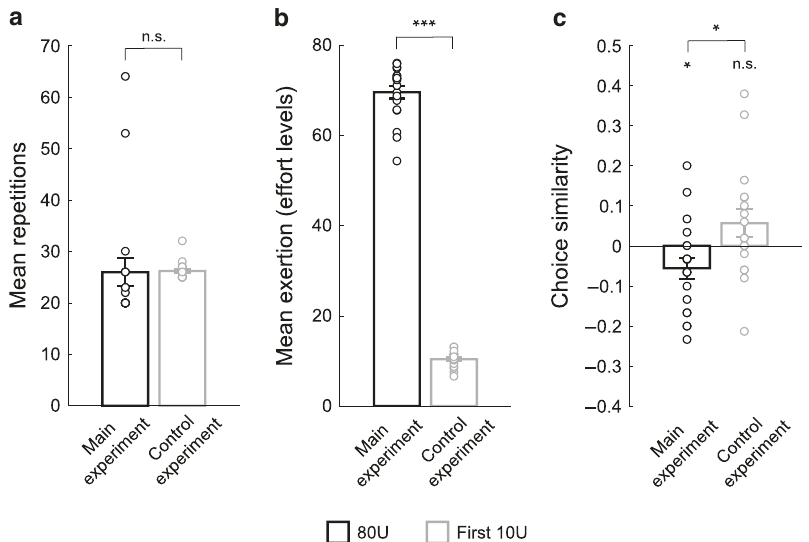
Fig. 7 Comparison of choice preferences during high and low exertion efforts, controlling for the number of exertion repetitions (participants from the Main Experiment and Control Experiment 2; n = 37). a We compared behavior during the fi rst 25 fatiguing exertions between the main experimental group ( fi rst 3 exertion and choice blocks) and the control experimental group ( fi rst 5 exertion and choice blocks). In the main experiment participants exerted at a level of 80U, and in the control experiment participants exerted 10U. Participants did not perform a signi fi cantly different number of exertion trials between these experimental epochs (Paired t -test (two-tailed): t 34 = 0.08, p = 0.94). Error bars indicate SEM. b Participants exerted signi fi cantly more effort in the main experimental group compared to the control experimental group (Unpaired t -test (two-tailed) comparing the mean effort produced between groups: t 34 = 38.83, p < 0.001). Error bars indicate SEM. *** p = 9.44 × 10 − 30 . c Comparison of choice similarity metrics between the main fatigue experiment and control experiment, averaged across the selected epoch. Relative to the baseline choice phase, positive values indicate more risk-seeking behavior in the subsequent choice phase, whereas negative values indicate more risk-averse behavior. There was a signi fi cant difference between choice behavior in the main and control groups (Unpaired t -test (two-tailed), t 34 = 2.60, p = 0.013). Participants in the control experimental group did not signi fi cantly alter their choice behavior during 10U exertion (Unpaired t -test (two-tailed) t 16 = 1.61, p = 0.126), while those in the main experimental group became signi fi cantly more risk-averse for effort during 80U exertions (two-tailed one-sample t 18 = 2.13, p = 0.047). These results indicate that changes in choice preferences are not simply the result of the experience of repeated exertions, but instead are induced by fatigue resulting from high intensity exertion. Error bars indicate SEM. * p <